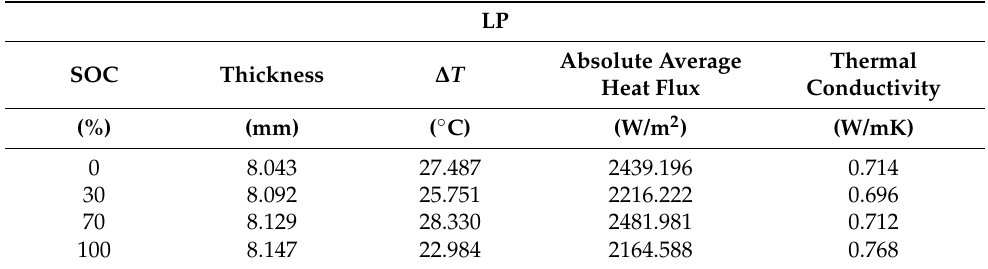
Table A3. Data used to calculate the thermal conductivity of cells aged under low